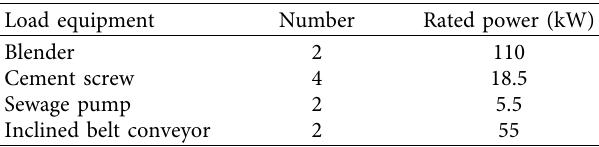
Table 4: Application